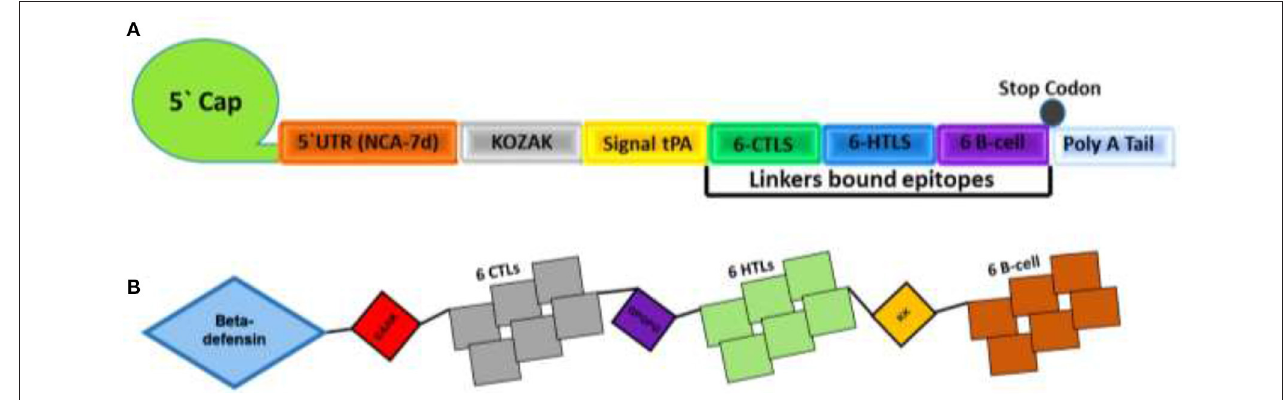
FIGURE 2 | Topological representation of the designed vaccines. (A) Final mRNA vaccine construct with an organized order of elements from left (N-terminal) to right (C-terminal). Each structural element, such as 5 ′ cap, 5 ′ UTR, Kozak Sequence, Signal protein, CTL epitopes, HTL epitopes, B-cell epitopes, 3 ′ UTR, and a Poly A tail, is represented by a different color scheme. (B) shows the final peptides-based vaccine construct with the adjuvant attached at N terminal and different epitopes are linked by EAAK, AAY, GPGPG and KK linkers.